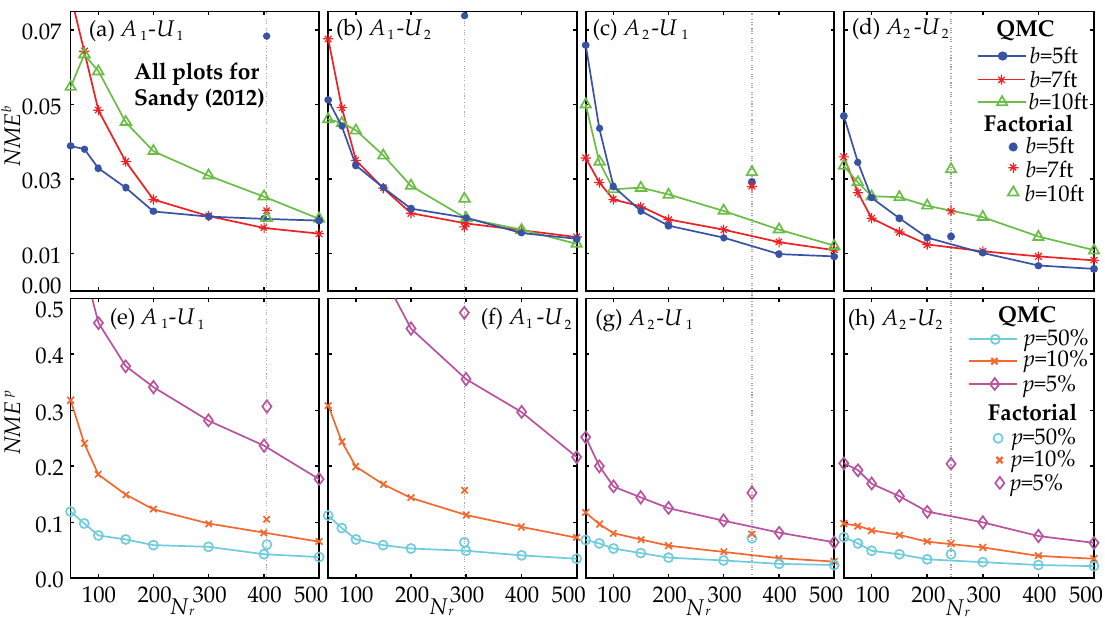
Figure 7. Normalized accuracy metrics NME b (top row) and NME p (bottom row) as functions of the number of samples N r used for hurricane Sandy (2012) for two different advisories and two uncertainty scenarios. First two columns correspond to advisory A 1 and uncertainty scenarios U 1 (first column) and U 2 (second column), while the two last columns correspond to advisory A 2 and uncertainty scenarios U 1 (third column) and U 2 (fourth column), respectively. Results for both the QMC (curves as function of samples) and the factorial sampling (for a specific sample size) are shown. A gray, dashed, vertical line is added to distinguish more easily the factorial sampling.